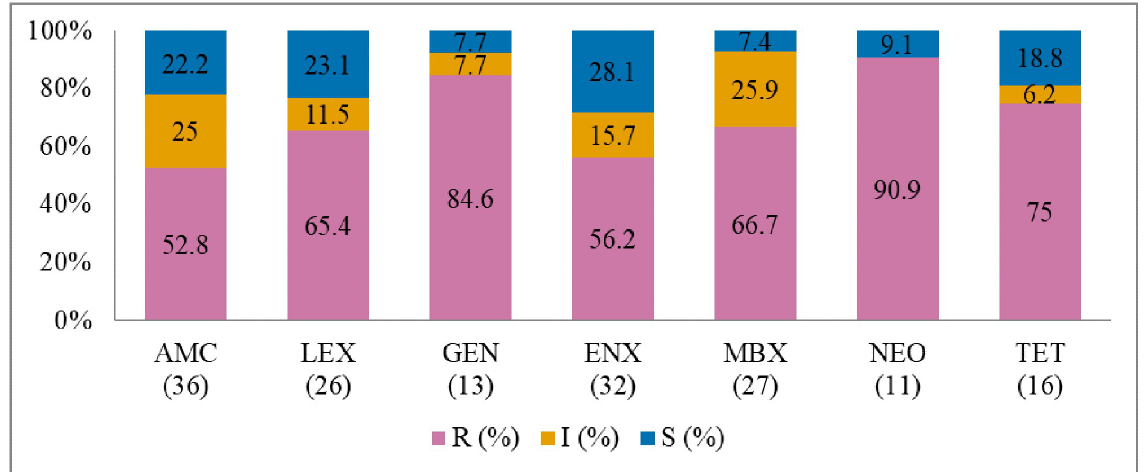
Fig 7. Antibiotic susceptibility pattern from Staphylococcus intermedius isolates from diseased dogs (January 2015-December 2017). R– resistance; I-intermediate; S–susceptible; AMC–amoxicillin/clavulanic acid; LEX–cephalexin; GEN–gentamicin; ENX–enrofloxacin; MBX– marbofloxacin; NEO-neomycin; TET–tetracycline. Numbers inside brackets ‘()’ indicate the total number of tested isolates for each